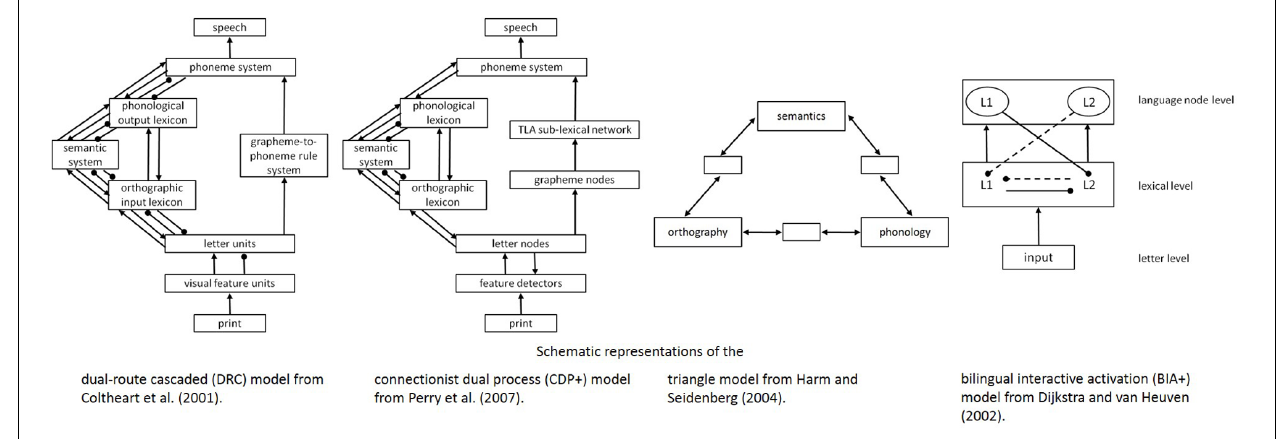
FIGURE 1 | Schematic representations of computational models of reading (aloud) and speech